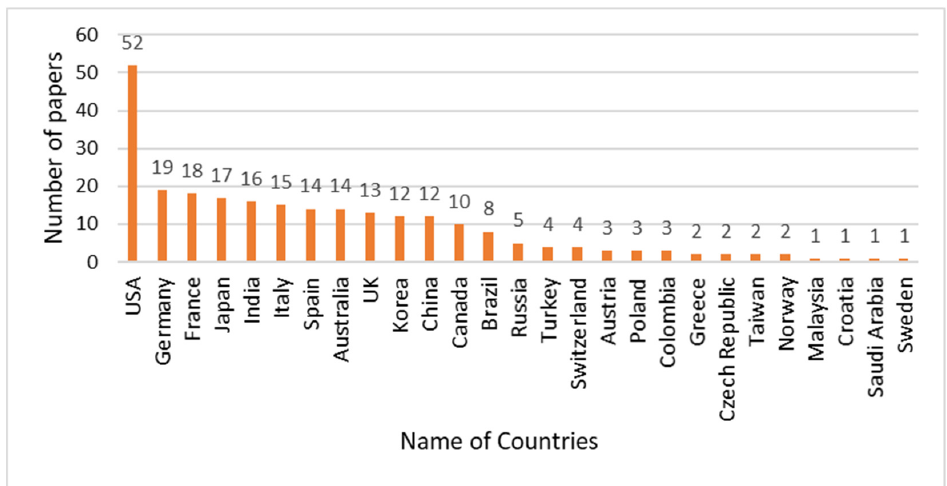
Figure 3. Number of papers published in the country of authors’ affiliation.